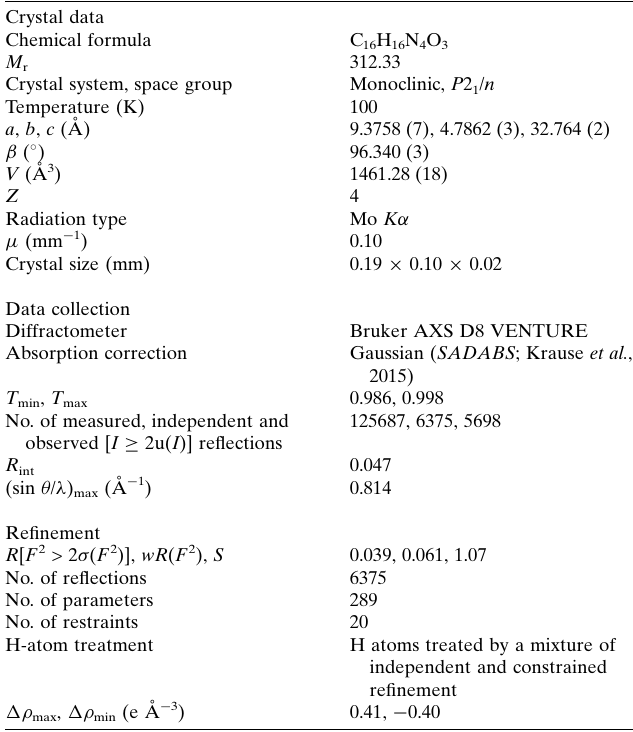
Crystal data Chemical